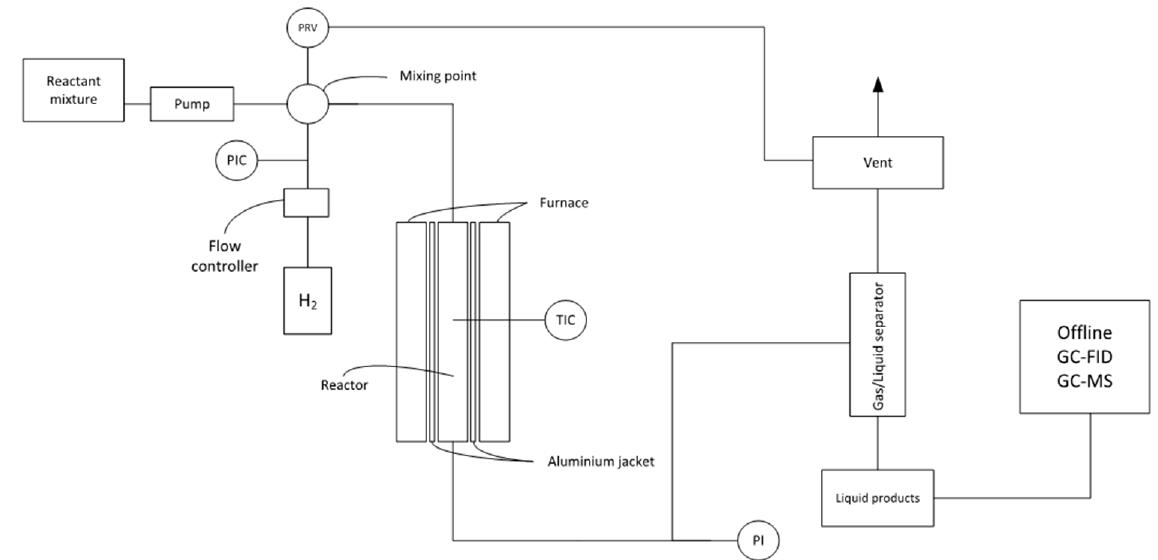
Figure 11. Schematics of the experimental setup.